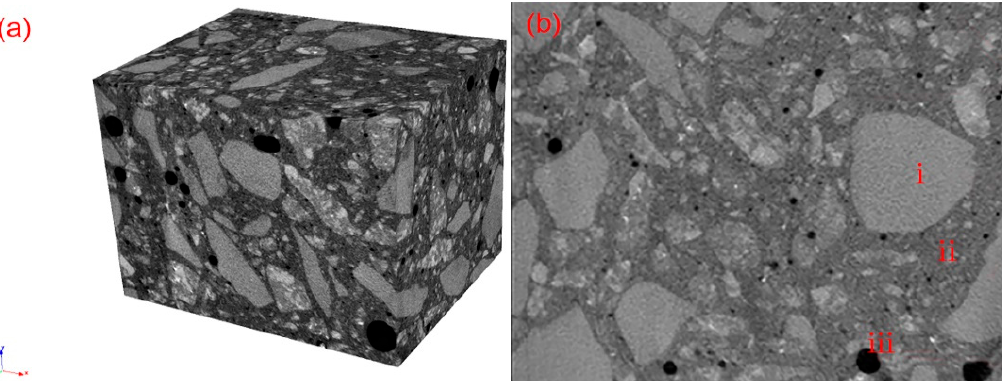
Figure 2. Grayscale treatment of CT, ( a ) 3D reconstruction; ( b ) CT slice image i: Aggregate, ii: Air void, iii: Asphalt mastic.